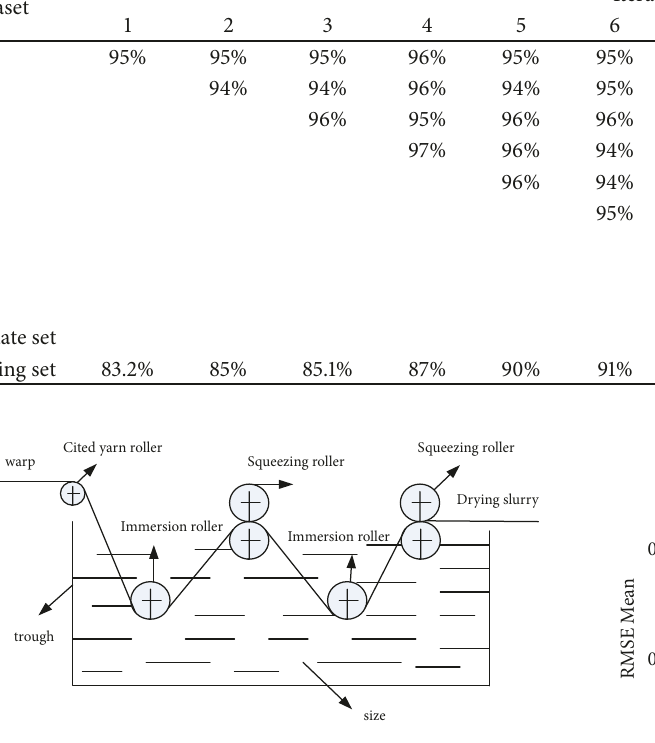
Figure 1: The double-dip and double pressure sizing processes.